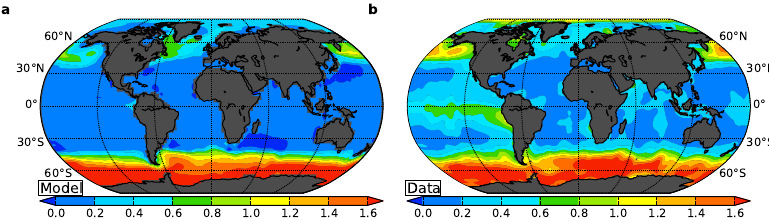
Figure 9. Phosphate distribution at the ocean surface (µmolkg − 1 ). Data from the World Ocean Atlas 2009 (Garcia et al., 2010b).